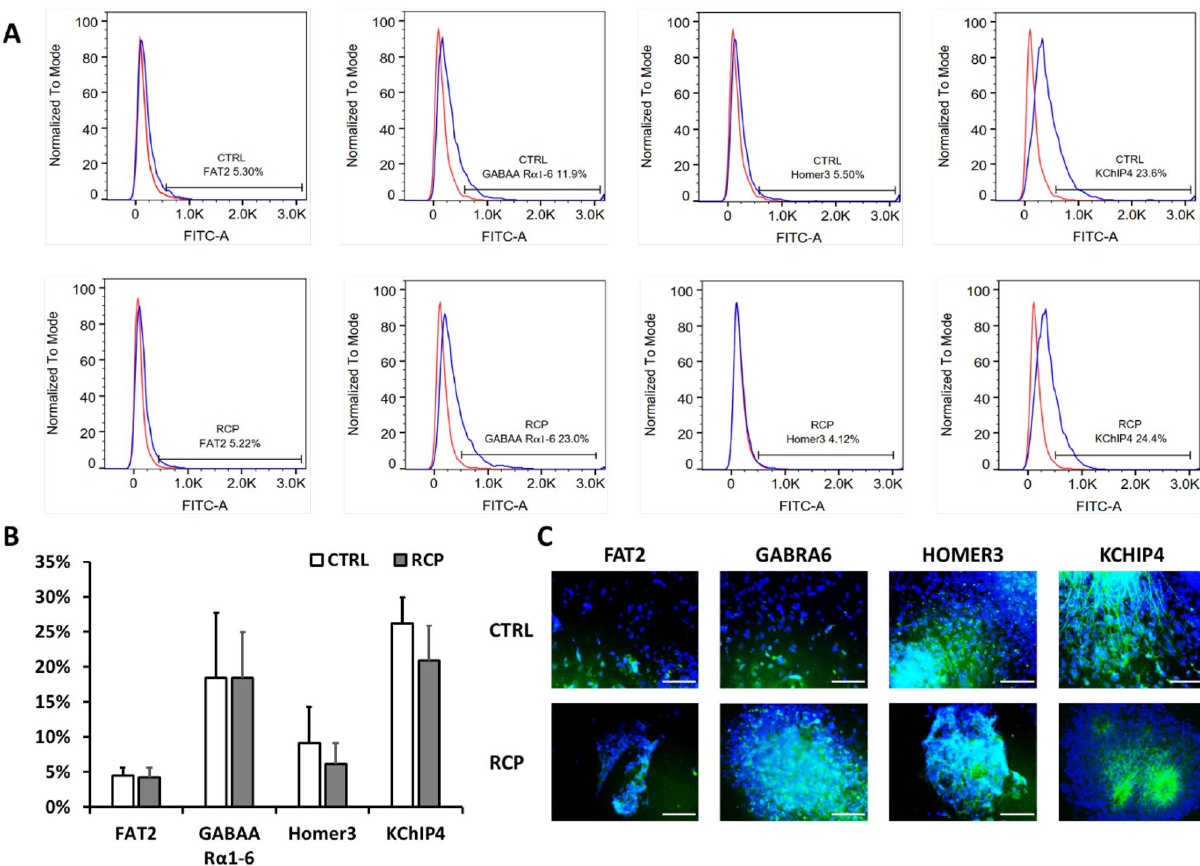
Figure 4. The expression of cerebellar layer-specific markers at protein levels. Four markers were selected for measuring the expression at the protein levels. ( A ) Flow cytometry histograms, red line: negative control; blue line: marker of interest. ( B ) Percentages of positive marker expression quantified by flow cytometry; ( C ) Immuno-fluorescent images. Scale bar: 100 µm. Blue: Hoechst 333342 for counterstaining with cell